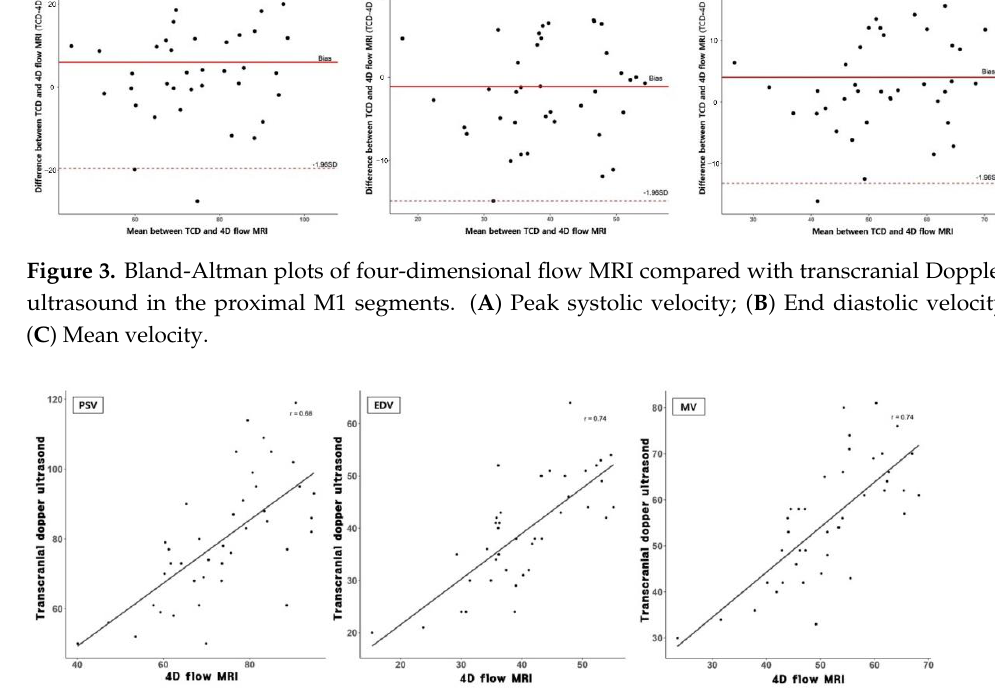
Figure 4. Correlation plots between four-dimensional flow MRI and transcranial Doppler ultra- sound in the proximal M1.